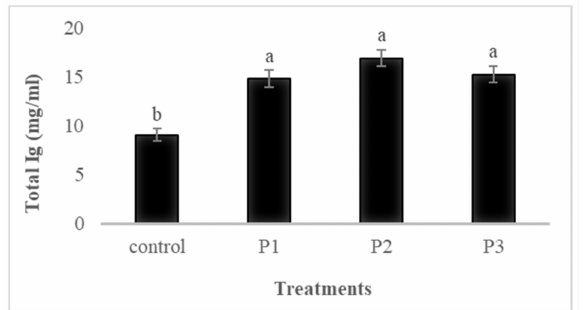
Figure 2. The effects of dietary pectin on serum total immunoglobulin level of rainbow trout fed four experimental diets with different inclusion levels control: 0, P1: 5, P2: 10, and P3: 20 g of apple pomace derived pectin (APDP) for 30 days. Bars assigned with different superscripts are significantly different ( p < 0.05); values are presented as the mean ± SE. ( n = 9).